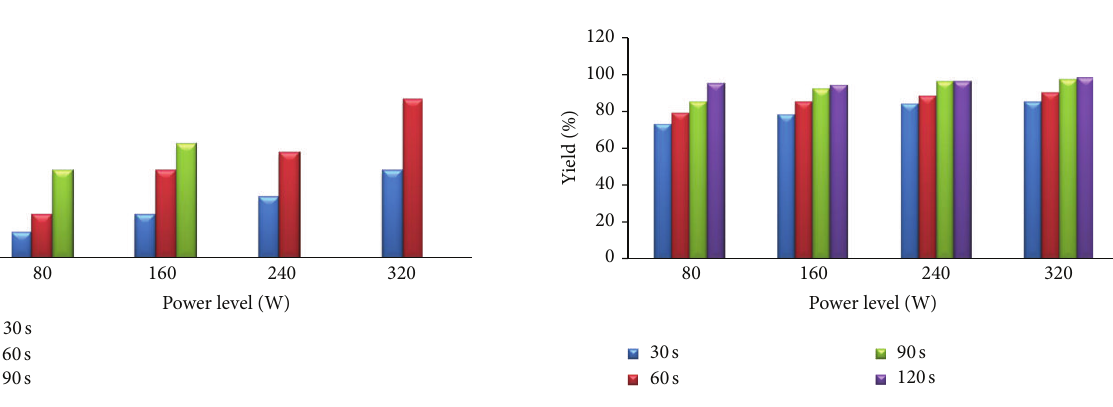
Figure 1: Power level versus % yield for the preparation of the compound (2a) under MWI method.